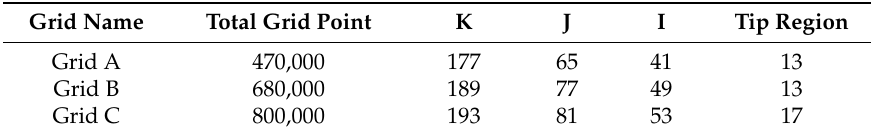
Figure 5. Schematic diagram of the grid and computational domain. ( a ) The length of the inlet and outlet duct; ( b ) whole domain; ( c ) the mesh in outer domain; ( d ) inner rotor mesh; ( e ) the grid on the rotor blade; ( f ) three-dimensional sector of the whole domain; ( g ) the geometry for concentric case; ( h ) the geometry for eccentric case. Table 3. Mesh statistic for 1 passage in the inner domain.